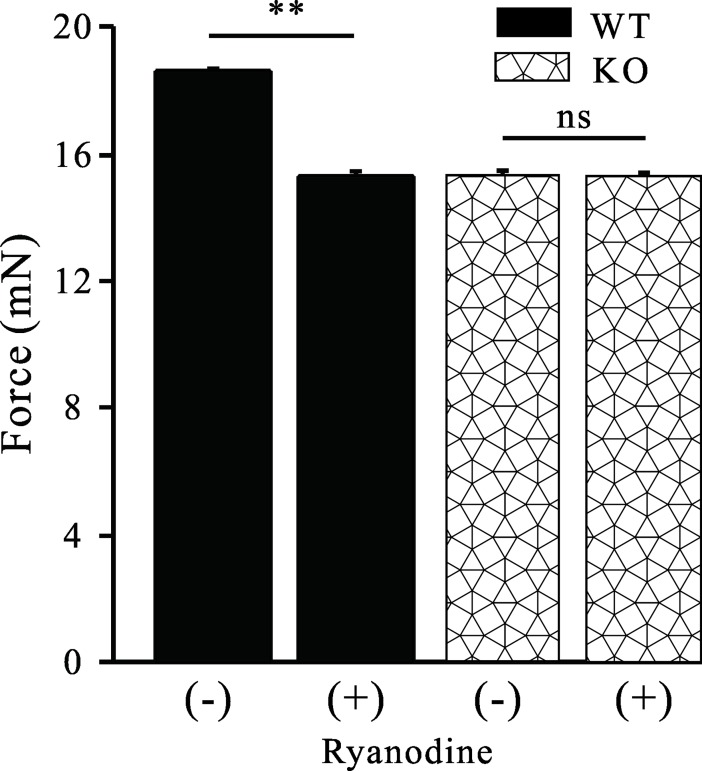
Deficiency of MTMR14 contributed to the decreased muscle contraction of the vas deferens.Vas deferens was isolated from age-matched WT and MTMR14-/- mice, and muscle contractions were measured. In WT mice, ryanodine significantly decreased the contraction of the vas deferens induced by high K+. In contrast, in MTMR14-/- mice, ryanodine failed to alter contraction of the vas deferens induced by high K+. **: P < 0.01. These data suggested that MTMR14 plays a role in contraction of the vas deferens in mice.